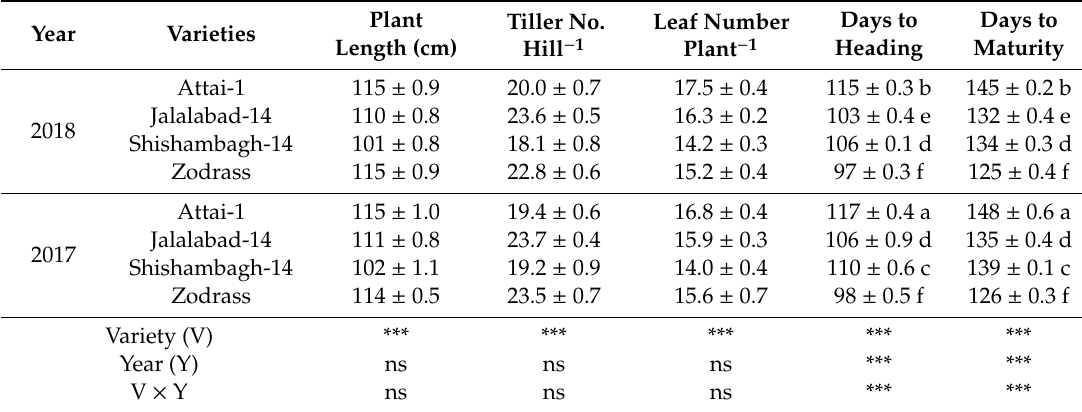
Table 3. Growth parameters of selected rice varieties.